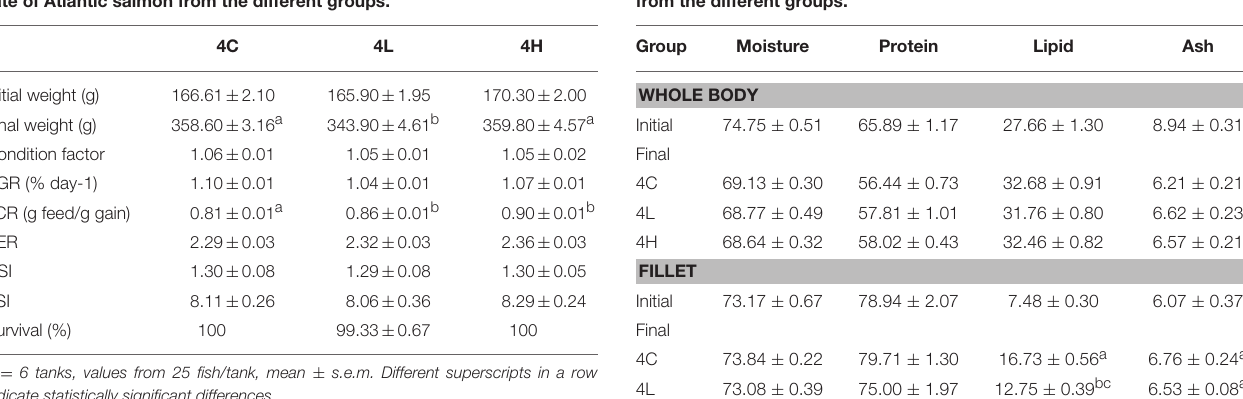
TABLE 5 | Proximate composition of Atlantic salmon (g/100g dry basis) from the different